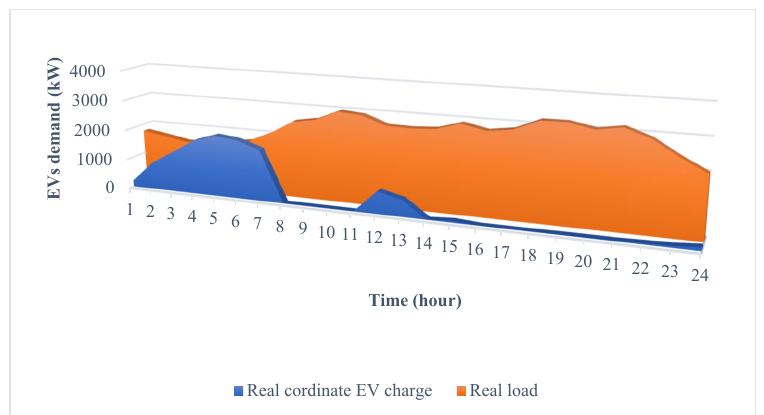
Figure 9. Impact of coordinated charging on the network load.